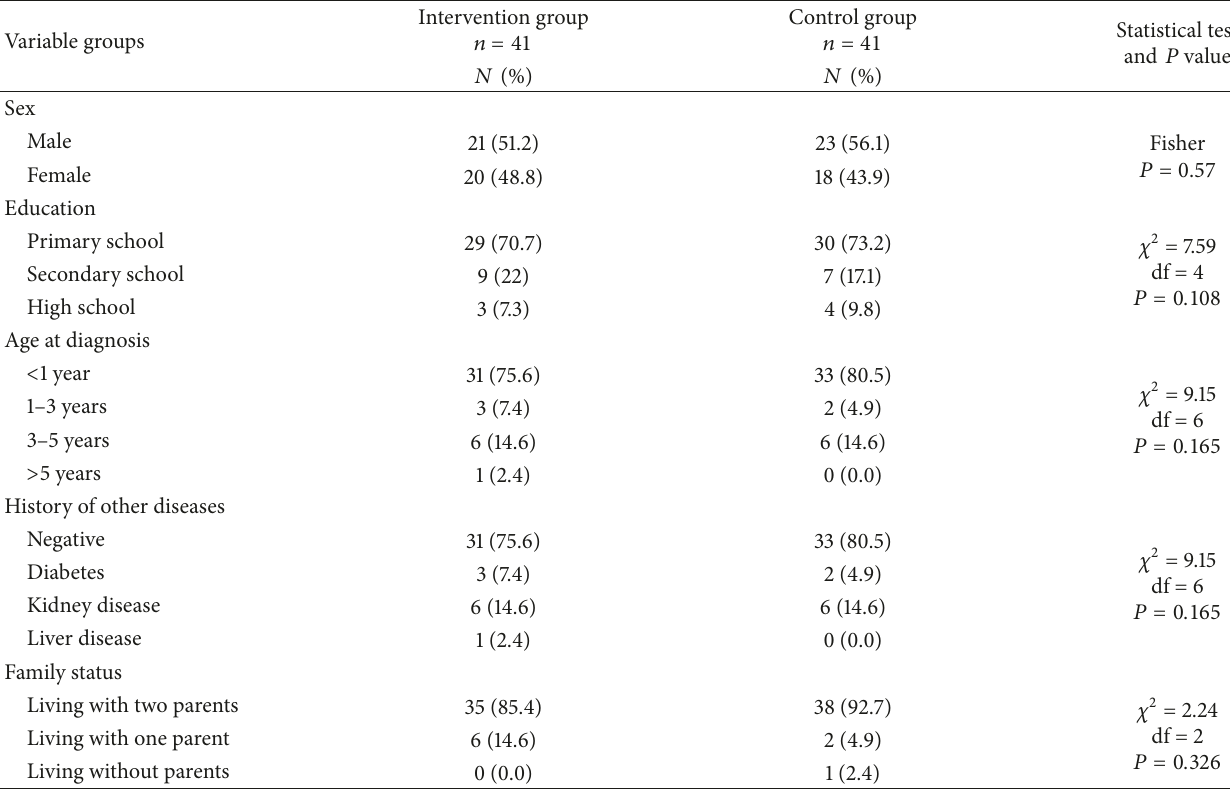
Table 2: The comparison of the variables between the experimental and control groups.